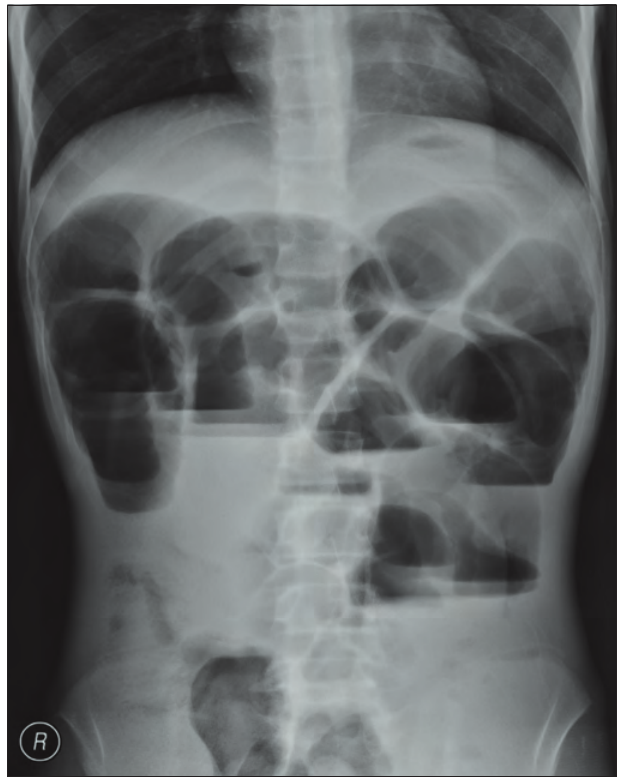
Fig. 1. Erect abdominal radiograph demonstrates dilated proximal small-bowel loops with multiple dynamic air-fluid levels in keeping with proximal small- bowel